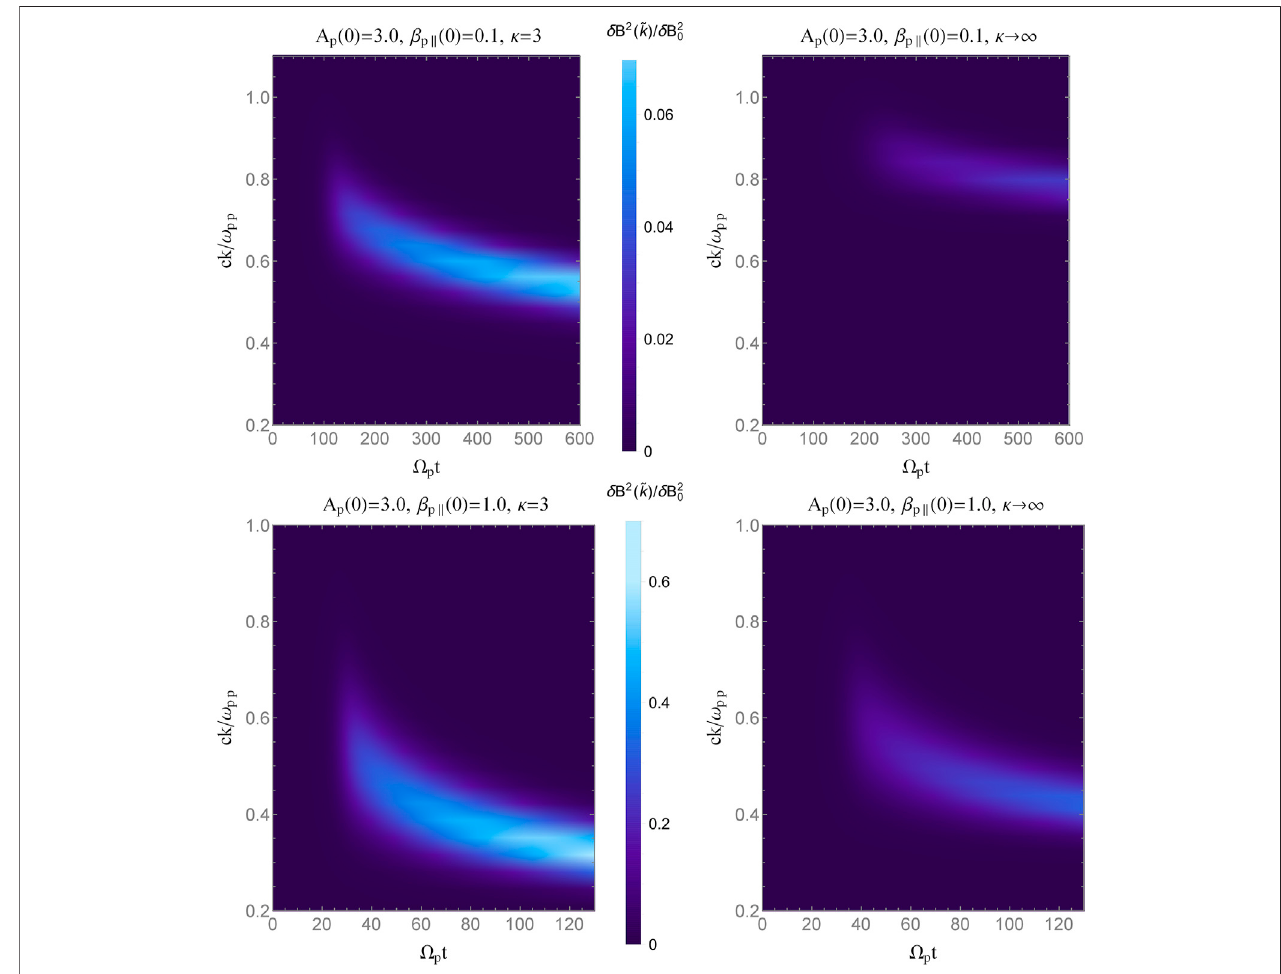
FIGURE 7 | Temporal variation of the wave-number spectra of EMIC magnetic wave energy density for the same cases in Figure 6 .